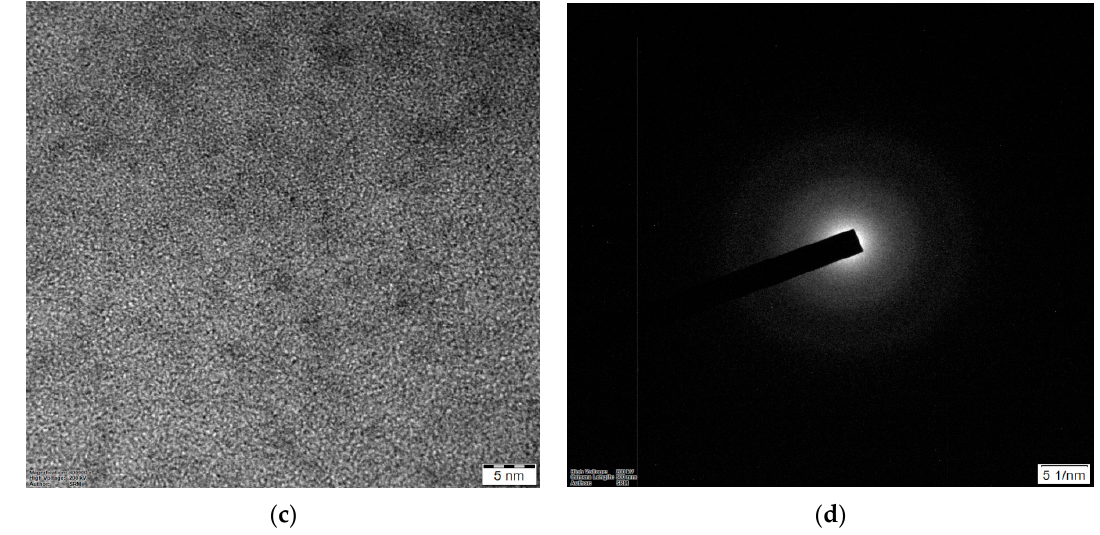
Figure 1. Transmission electron microscopy (TEM) images of the synthesized bismuth nanoparticles with image focus zoom 50 nm ( a ), 20 nm ( b ), and 5 nm ( c ). ( d ) selected area electron diffraction